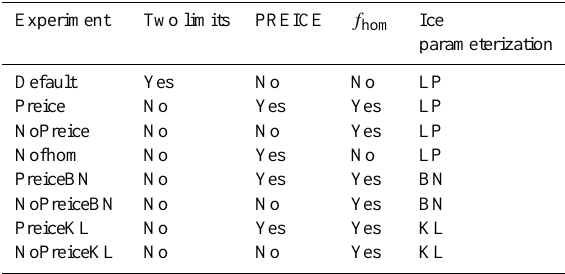
Table 1. List of experiments conducted in this